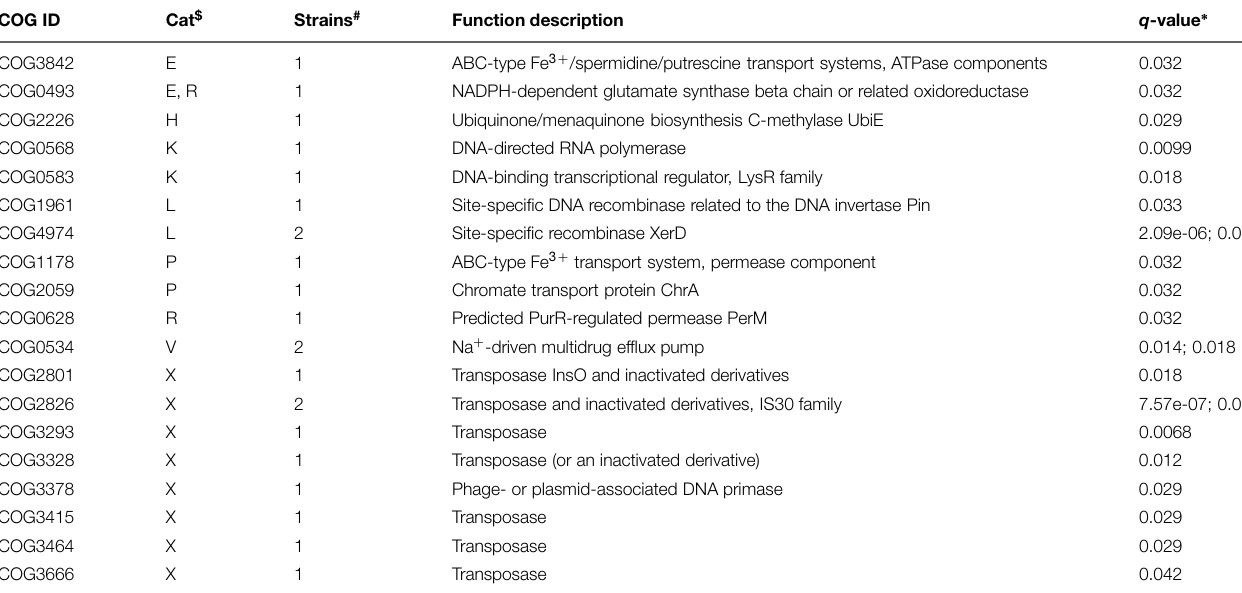
FIGURE 8 | Sharing of genes with antisense transcription among human individuals. Genes associated with Streptococcus anginosus C238 (A) , Bacteroides vulgatus ATCC 8482 (B) and Parabacteroides distasonis ATCC 8503 (C) tend to be unique to different individuals, while genes associated with Methanobrevibacter smithii ATCC 35061 tend to be shared by individuals (D) . The numbers below the bars indicate the number of individuals sharing the genes with antisense transcription, with 1 indicating the number of genes unique to one individual, and 2–8 for genes shared by two individuals, and then increasing numbers of individuals. TABLE 1 | Clusters of Orthologous Groups (COG) functions that are enriched in the genes with antisense transcription in 47 strains ( q -value < = 0.05 by Fisher’s exact test with FDR